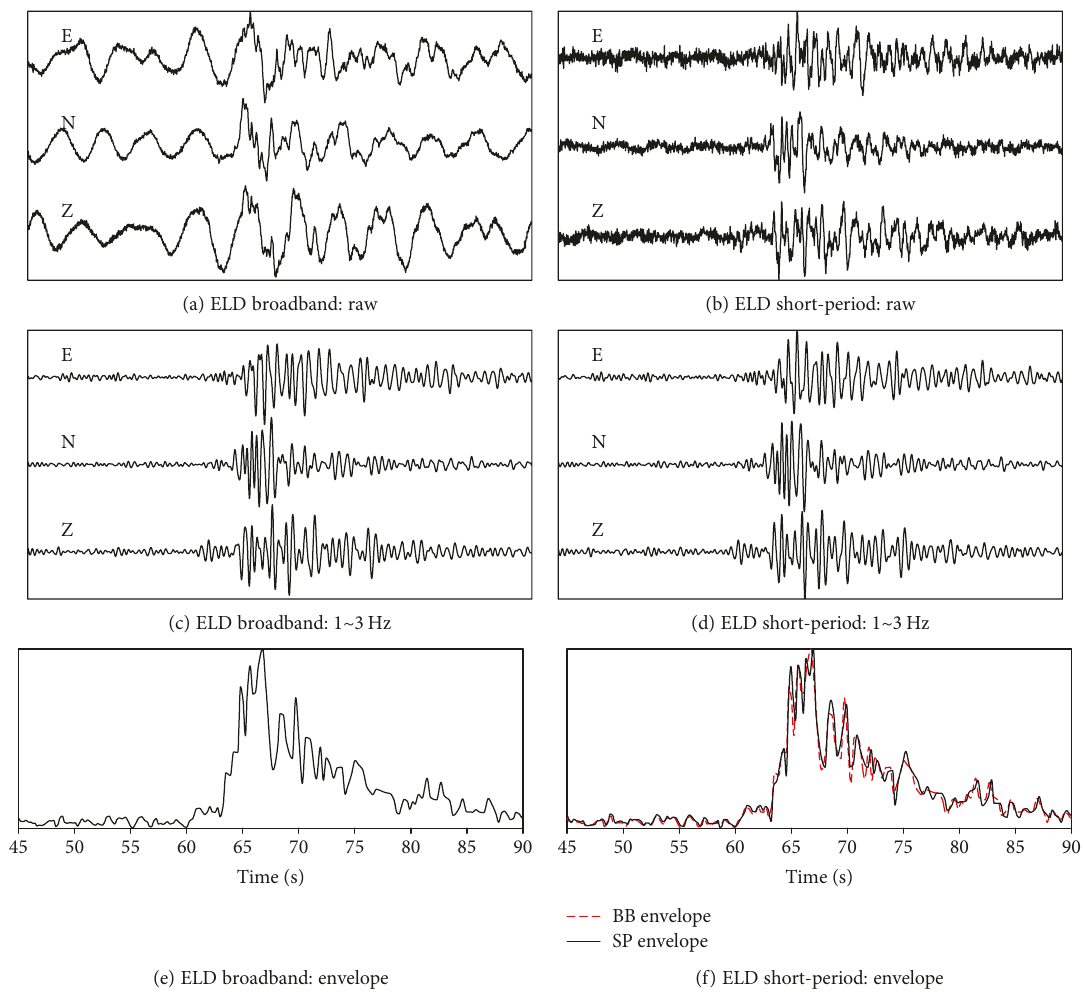
Figure 2: The three-component, east, north, vertical (Z), seismic recordings of a landslide event at the station ELD, where broadband (left) and short-period (right) instruments are colocated. (a, b) Raw waveform data and (c, d) bandpass- fi ltered (1 ~ 3Hz) broadband and short-period waveforms. (e, f) The envelopes of bandpass- fi ltered broadband and short-period three-component root-mean-square waveforms (section